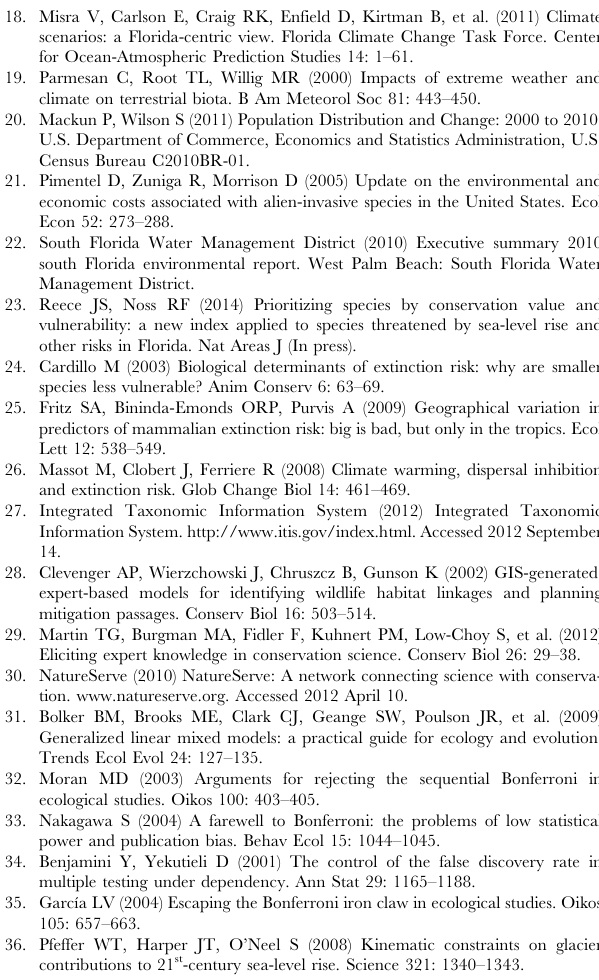
Table S1 List of criteria in each module for the Standardized Index for Vulnerability and Value Assess- ment